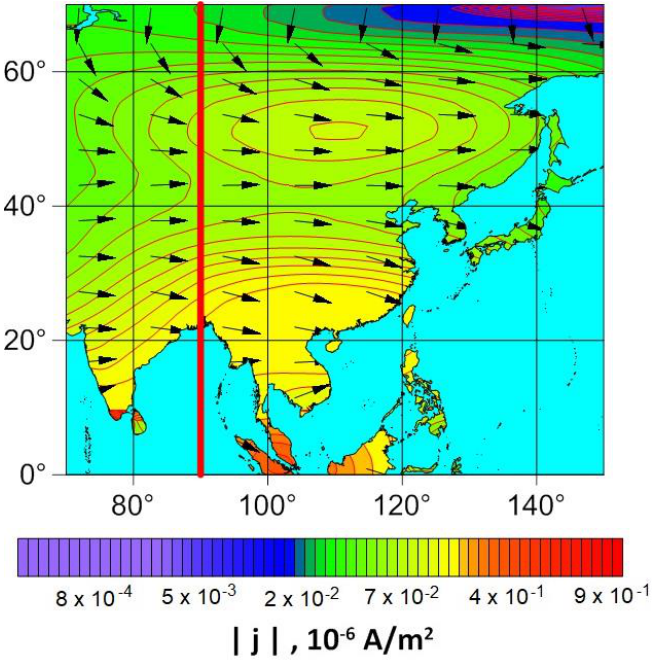
Figure 15. Spatial distribution of the amplitude of the maximum electric current density module and the direction of its vector in the region limited by coordinates 0–70 ◦ N, 70–150 ◦ E. The red vertical line shows the position of the subsolar meridian.